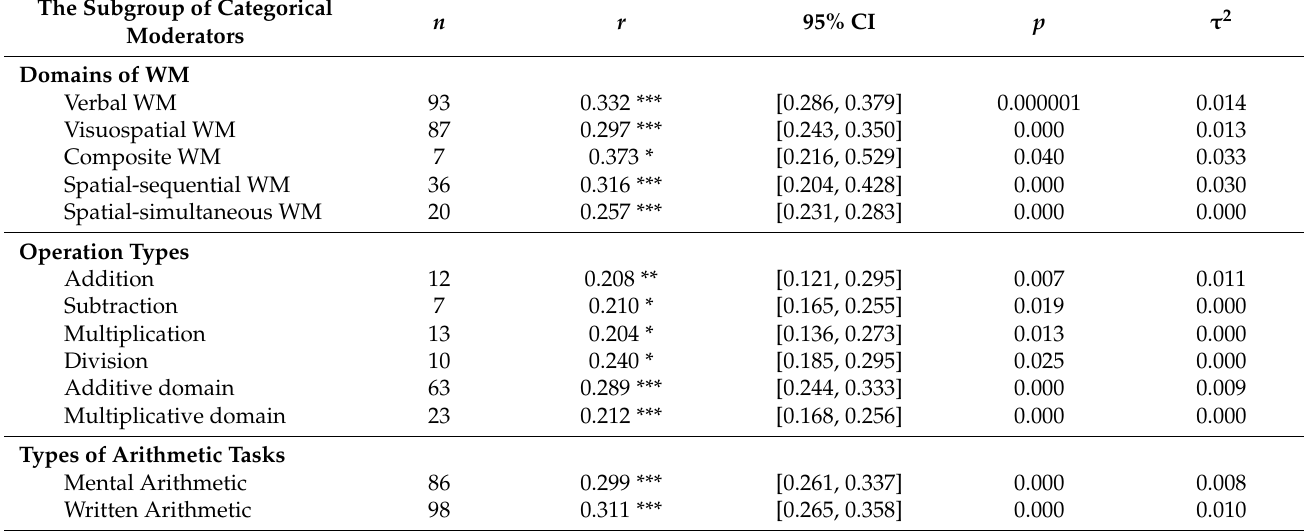
Table 2. The mean correlation between working memory and arithmetic for each